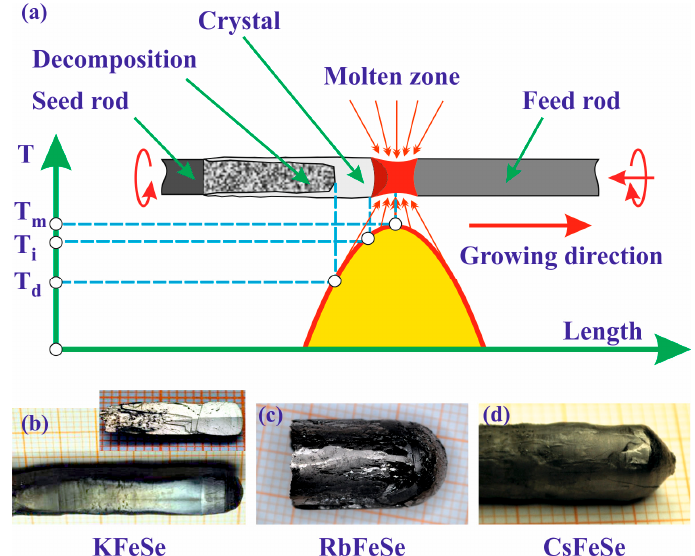
Figure 2. Optical floating-zone (OFZ) growth setup ( left ); and snapshot ( right ) of the real iron-based superconductor growth process.